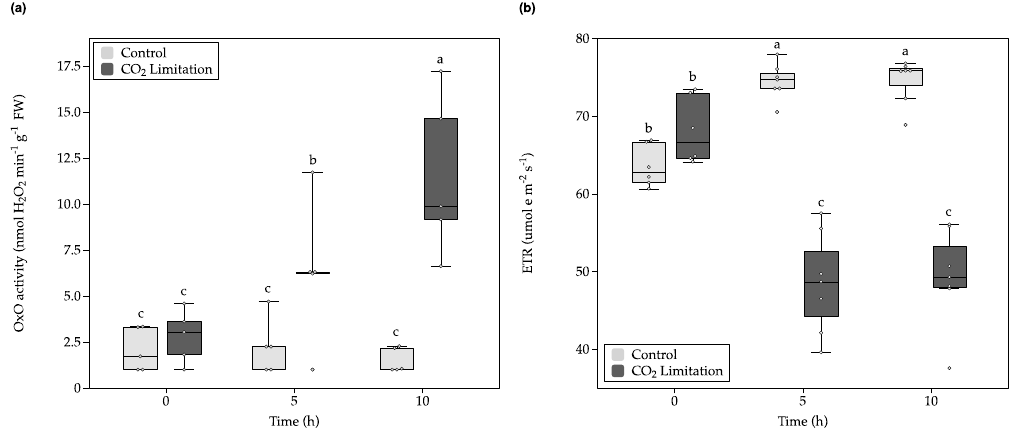
Figure 3. Fluctuations in the oxalate oxidase activity (OxO) ( a ), and electron transport rate (ETR) ( b ) of C. quitensis plants under ambient or low CO 2 concentration. Plants were kept over time under constant light in airtight chambers injected either with ambient air (Control, 400 ppm CO 2 , white boxes) or filtered air with soda lime (CO 2 limitation, 11.5 ppm CO 2 , gray boxes). The horizontal line indicates the mean and length of each whisker indicates the interquartile range (IQR); n = 5. Di ff erent letters represent statistically significant di ff erences (two-way ANOVA; p < 0.05).